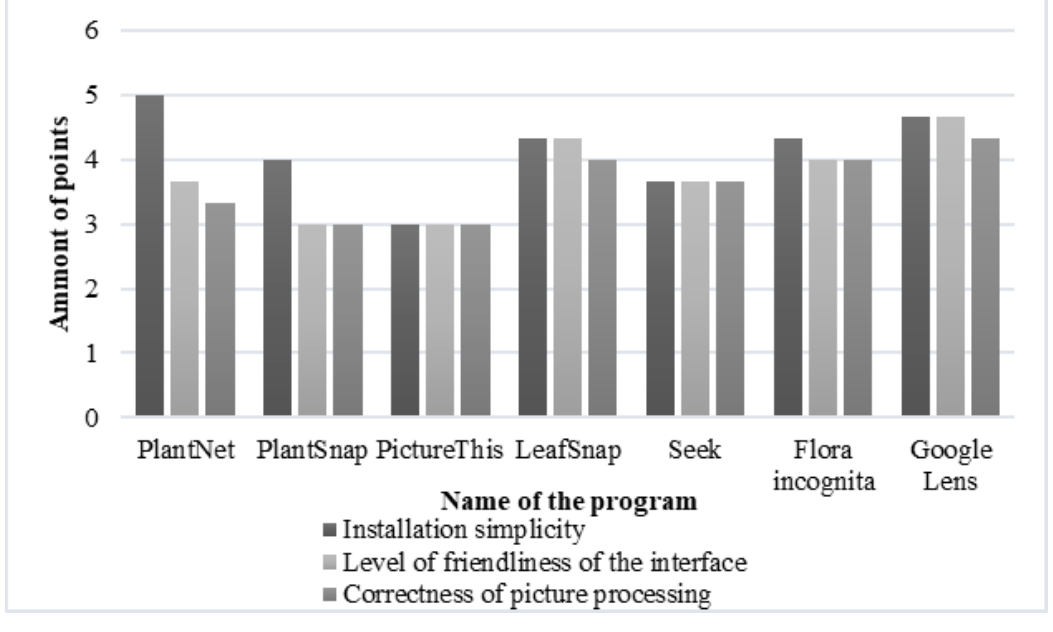
Figure 11: Presentation of paper